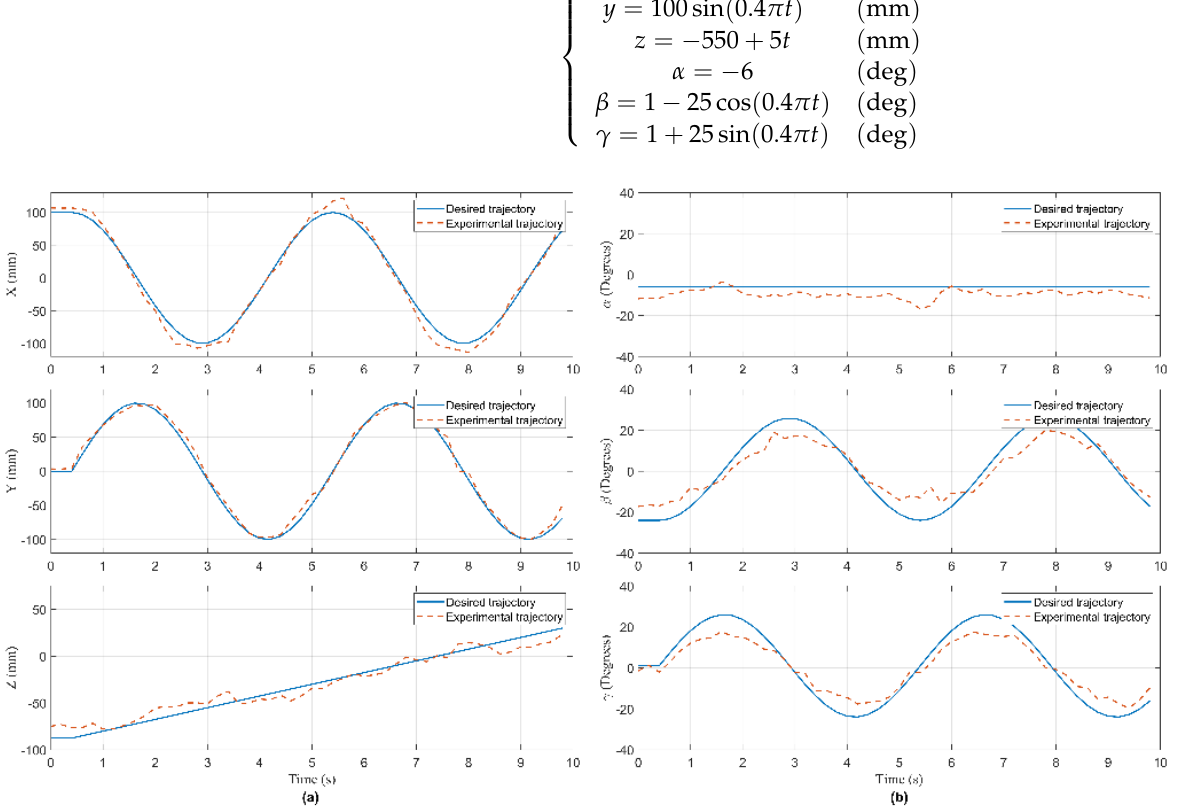
Figure 14. The pose of the end-effector in Case 2: ( a ) The position of the end- effector; ( b ) the orientation of the active plate.